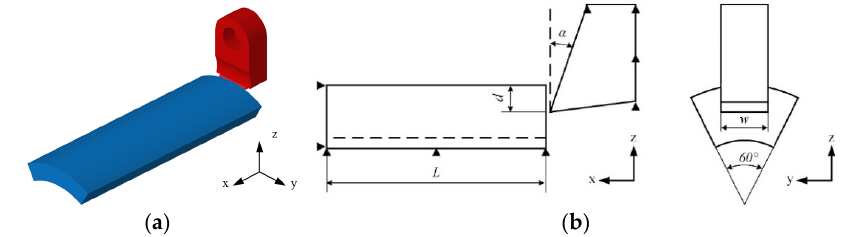
Figure 4. ( a ) Tool-tube finite element model and ( b ) structural parameters.